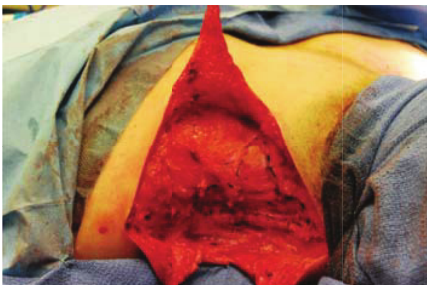
Figure 2: Markings for an M-T rearrangement. An incision is marked perpendicular to the web to form a “T.” This incision is parallel to a crease in the anterolateral neck. The length of this incision is determined by the pinch test. Then, a triangular flap whose apex is at the intersection of the limbs of the “T” is marked. This is an equilateral triangle, with the limbs and base of the triangle measuring the same length as the releasing incision. The base of the triangularflapisthenconnectedtothesuperiorandinferioredgesof the webbing to form an “M.” Note that the inferolateral displacement of hair-bearing skin is present within the superior triangle.